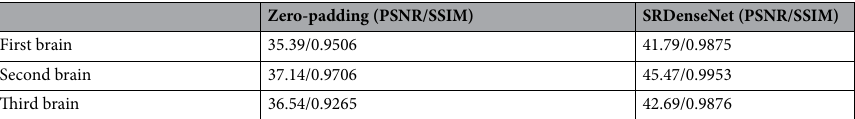
Table 1. PSNR and SSIM values of the reconstructions obtained by zero-padding the k-space data for and by applying SRDenseNet to the three different MR brain images shown in Fig.